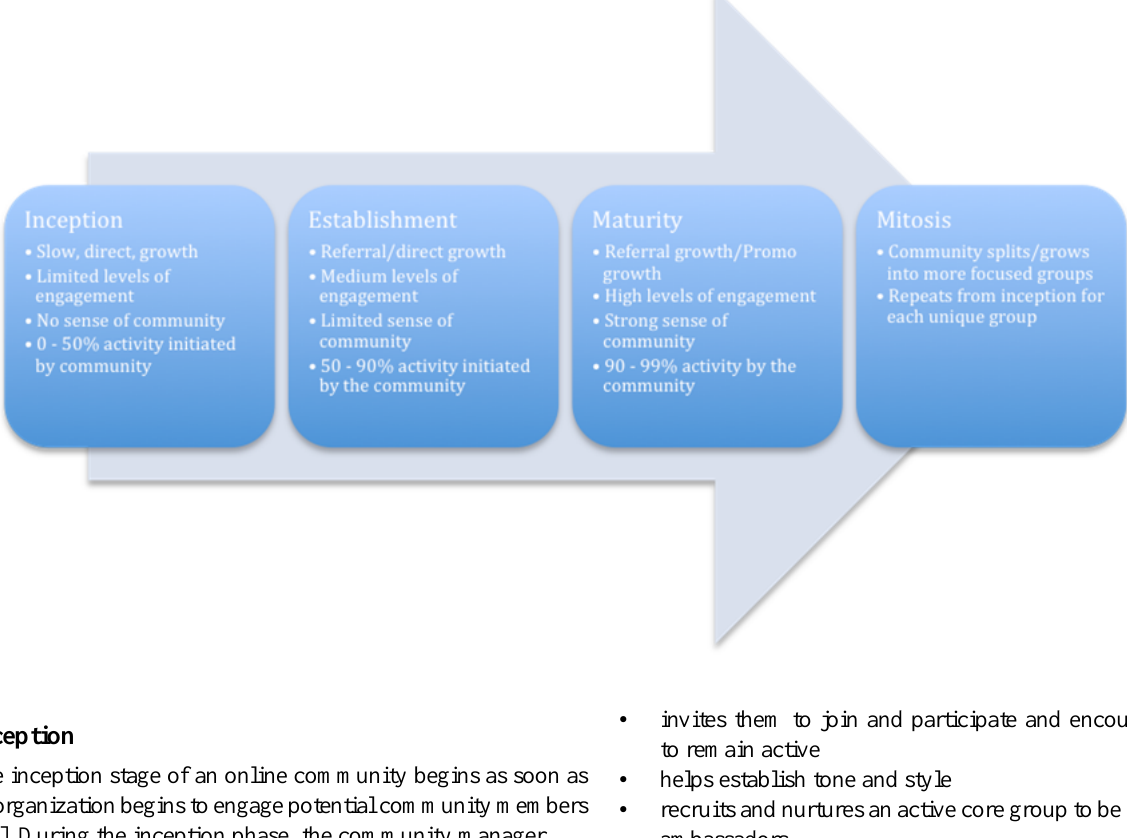
Figure 2. Life cycle of an online community (by Richard